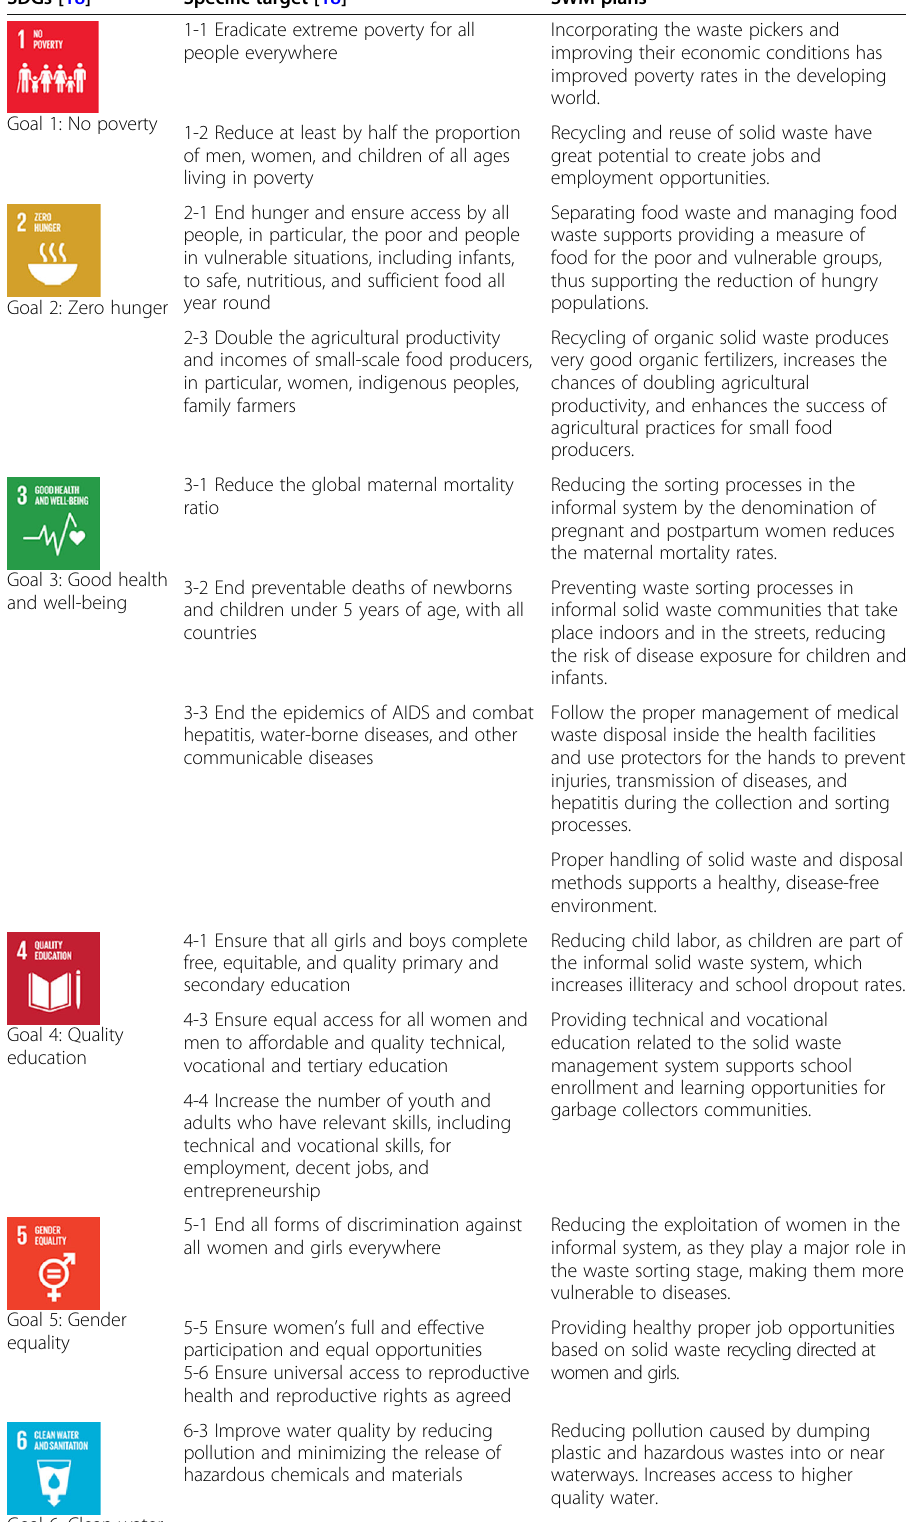
Table 1 The contribution of SWM on SDGs achievement [the author] SDGs [18] Specific target [18] SWM